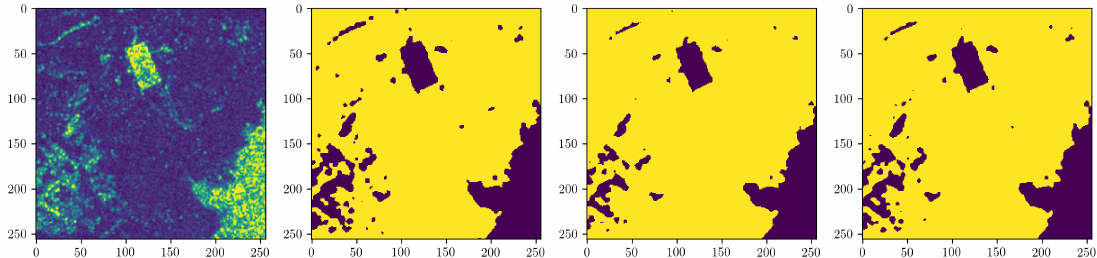
Figure A1. From left to right: raw SAR tiles using the viridis colormap followed by tiles of different analyses esponding to classical histogram based, baseline and neural network predictions. The background is displayed in purple and flood in